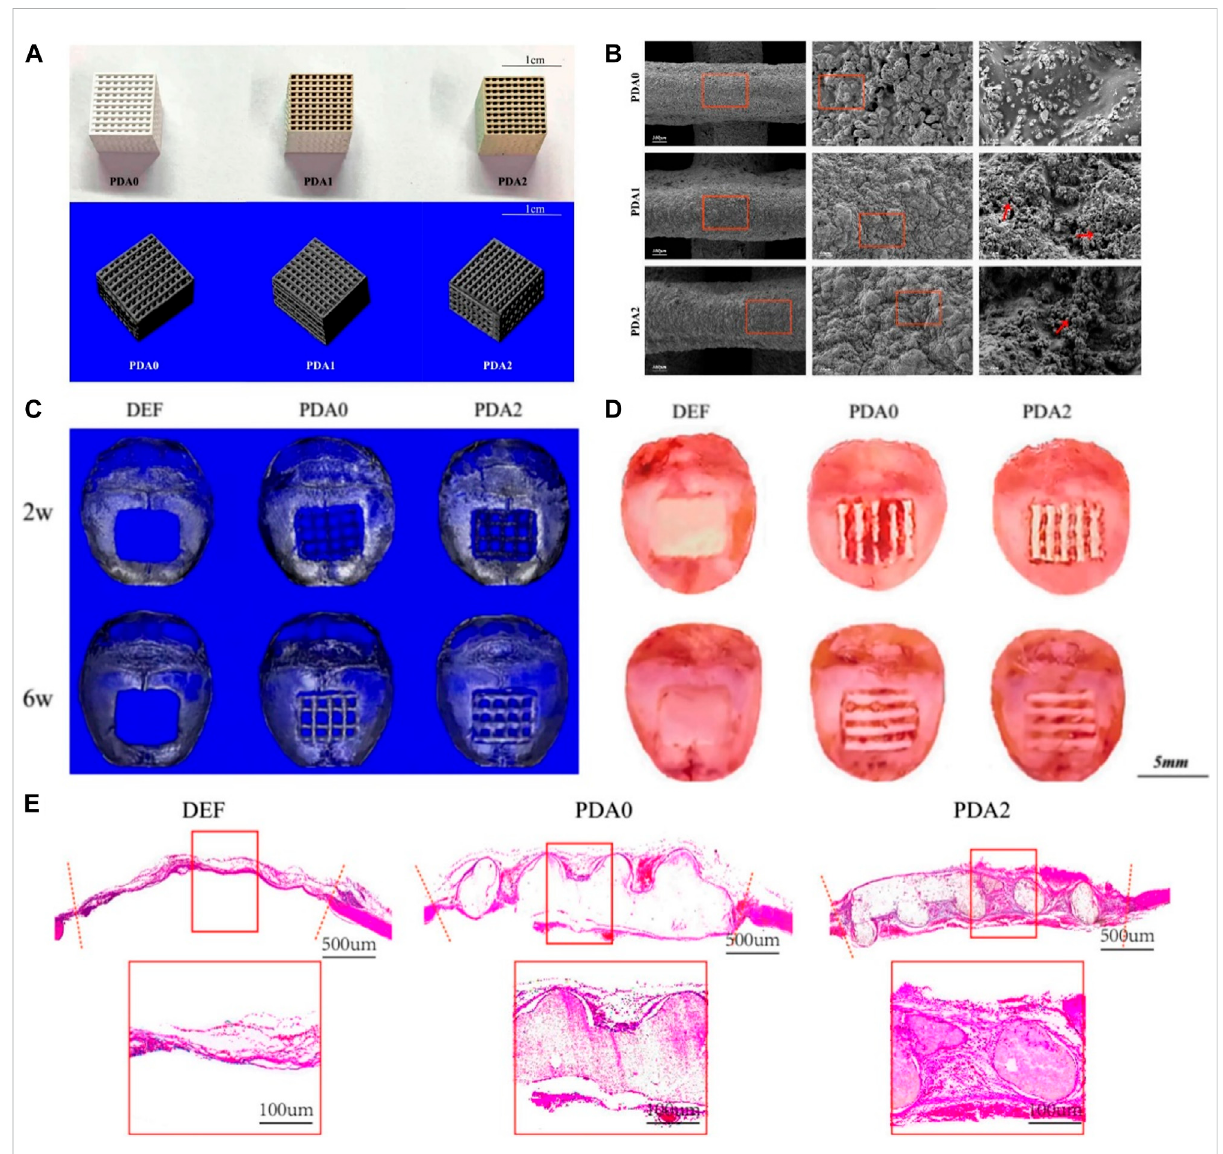
3D-Printed PLGA/ β -TCPscaffold coatedwithpolydopamineforbonetissue engineering (Xuetal.,2019). (A) Overallappearanceandmicro-CT of 3D-printed PLGA/ β -TCP composite scaffold with different content of PDA. (B) SEM images of 3D-printed PLGA/ β -TCP composite scaffold with differentcontentofPDA. (C) Micro-CTreconstructedimagesof3D-printedPLGA/ β -TCPcompositescaffoldafterscaffold-implantationsurgery. (D) Gross specimen images of 3D-printed PLGA/ β -TCP composite scaffold after scaffold-implantation surgery. (E) HE staining photos of